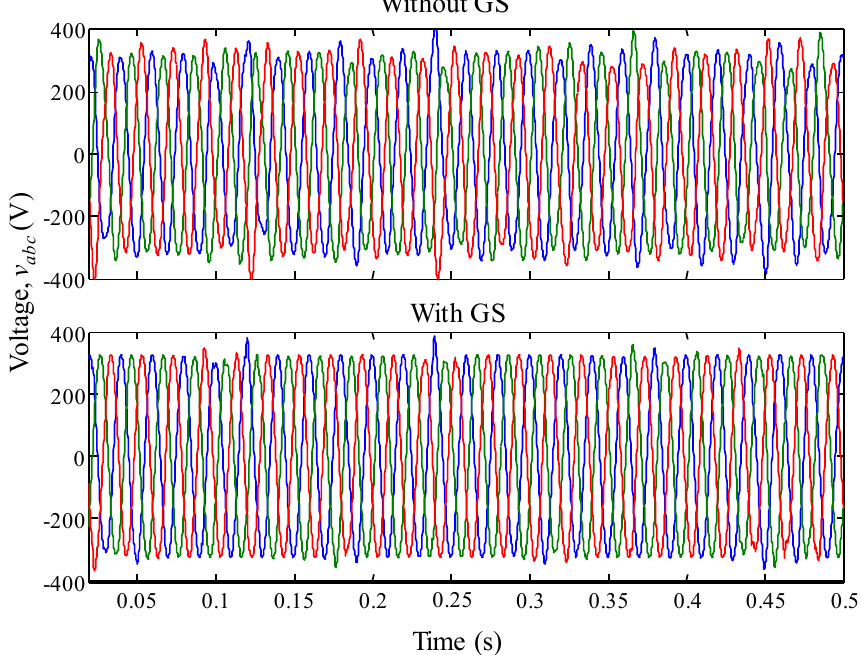
Figure 17. Three-phase voltage obtained at the inverter filter output with the two different controllers in the presence of a current disturbance corresponding to